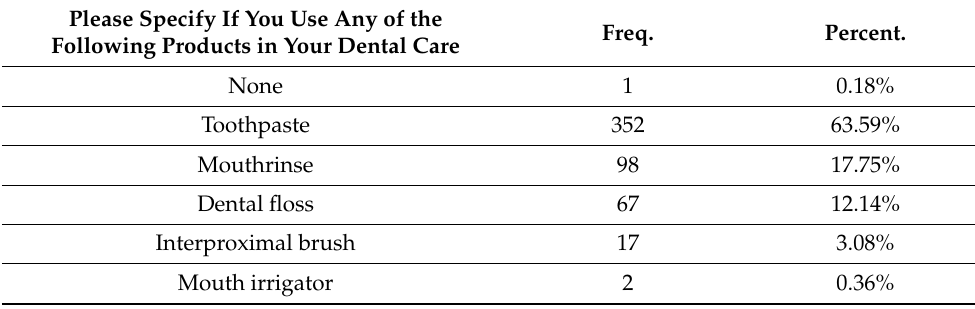
Table 4. Use of oral hygiene